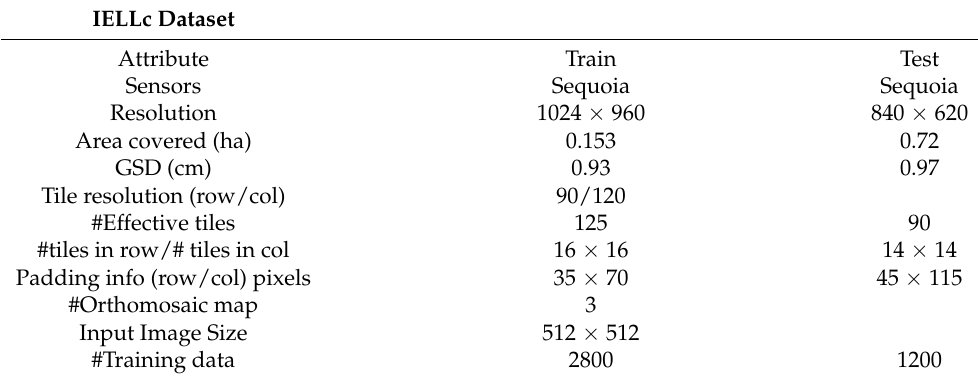
Table 2. Distribution of Training and Testing Dataset of IELLc